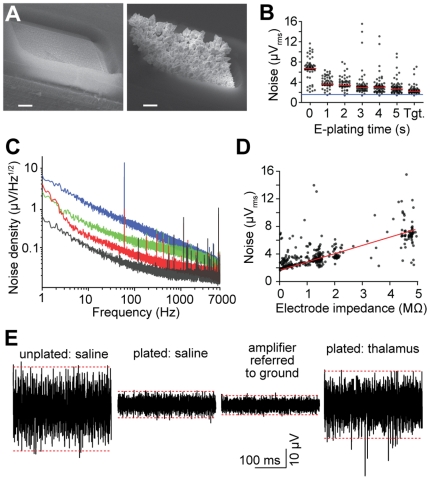
Low noise performance of the multiplexed recording system.(A) Scanning electron micrographs of 108 µm2 electrodes in their original fabricated state (left), and after gold electroplating to an impedance of 0.15 MΩ. Scale bars, 2 µm. (B) Root-mean-square noise of the electrophysiological recording system as a function of electroplating time. Measurements were performed in phosphate buffered saline. Tgt. denotes plating proceeded until a target impedance of 0.4 MΩ per channel was achieved. Signals correspond to the 0.1–6.5 kHz frequency band. Black points denote individual channels; red lines represent median value of 64 sites; the blue line corresponds to the input-referred noise floor of the amplifiers. (C) Amplifier noise spectral density of a 0 (black), 0.4 (red), 2.2 (green), and 4.9 MΩ (blue) impedance electrical connection to ground. (D) Root-mean-square noise in the 0.1–6.5 kHz band as a function of electrode impedance at 1 kHz. The red line is for illustration purposes. (E) Segments of single-site recordings under various electroplating and environmental conditions. Dashed red lines represent the 99.9th percentile range of the voltage. Unplated and plated electrodes have an impedance of 4.9 and 0.3 MΩ, respectively. The thalamic recording was carried out in a mouse under chloral hydrate anesthesia. Note that the noise level for a plated probe in thalamus is lower than that of an unplated probe in saline, in spite of background neural activity.